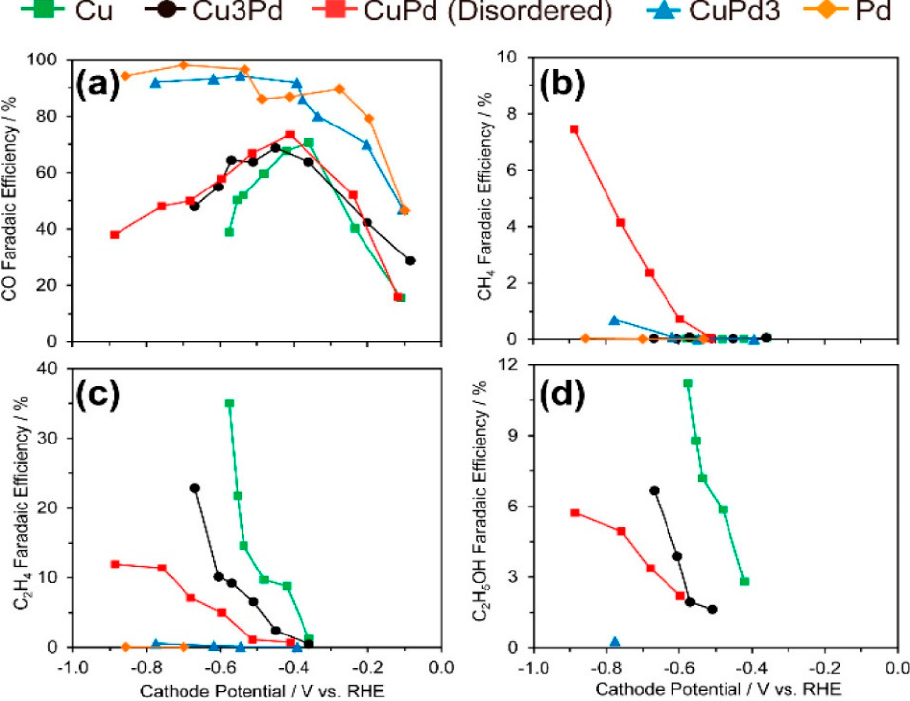
Figure 8. Faradaic efficiencies for ( a ) CO; ( b ) CH 4 ; ( c ) C 2 H 4 ; and ( d ) C 2 H 5 OH for catalysts with different Cu:Pd ratios: Cu, Cu 3 Pd, CuPd, CuPd 3 , and Pd. Reprinted (adapted) with permission from [67]. Copyright 2017 American Chemical Society.